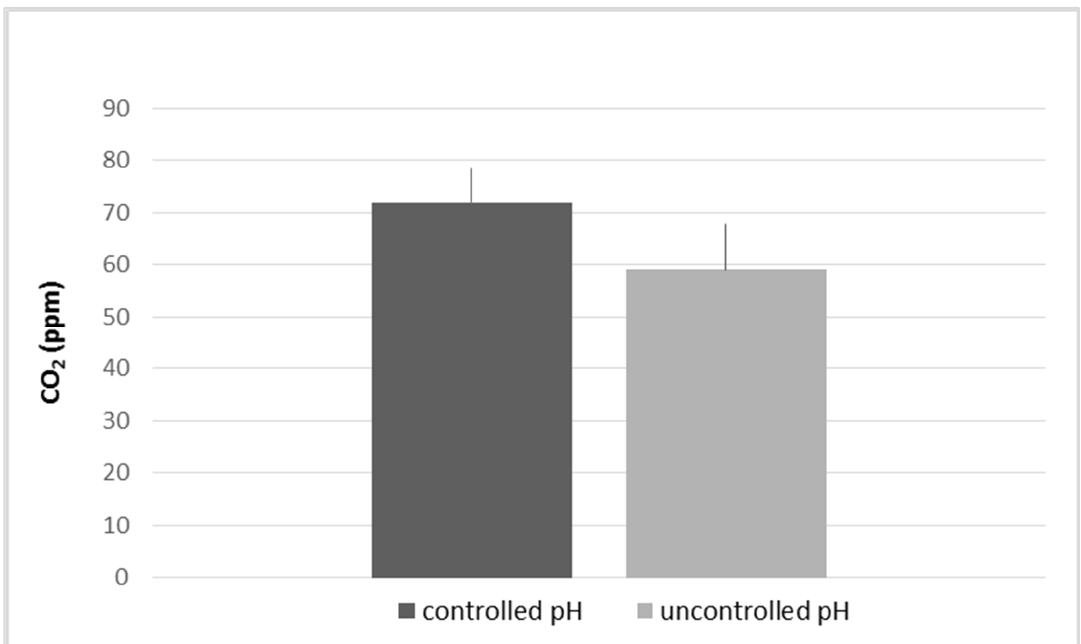
Figure 6. N bio filtration efficiency (percent) and standard error at the end of the three experimental weeks.